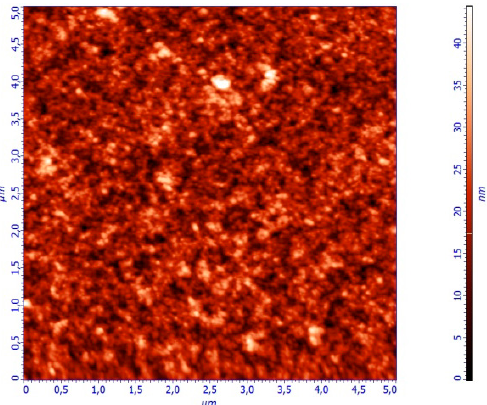
Figure 2. Surface nanotopography of a representative PEDOT:PSS film (formulation PH1000) as measured by AFM. The root mean square (rms) roughness value is measured at 4 nm.